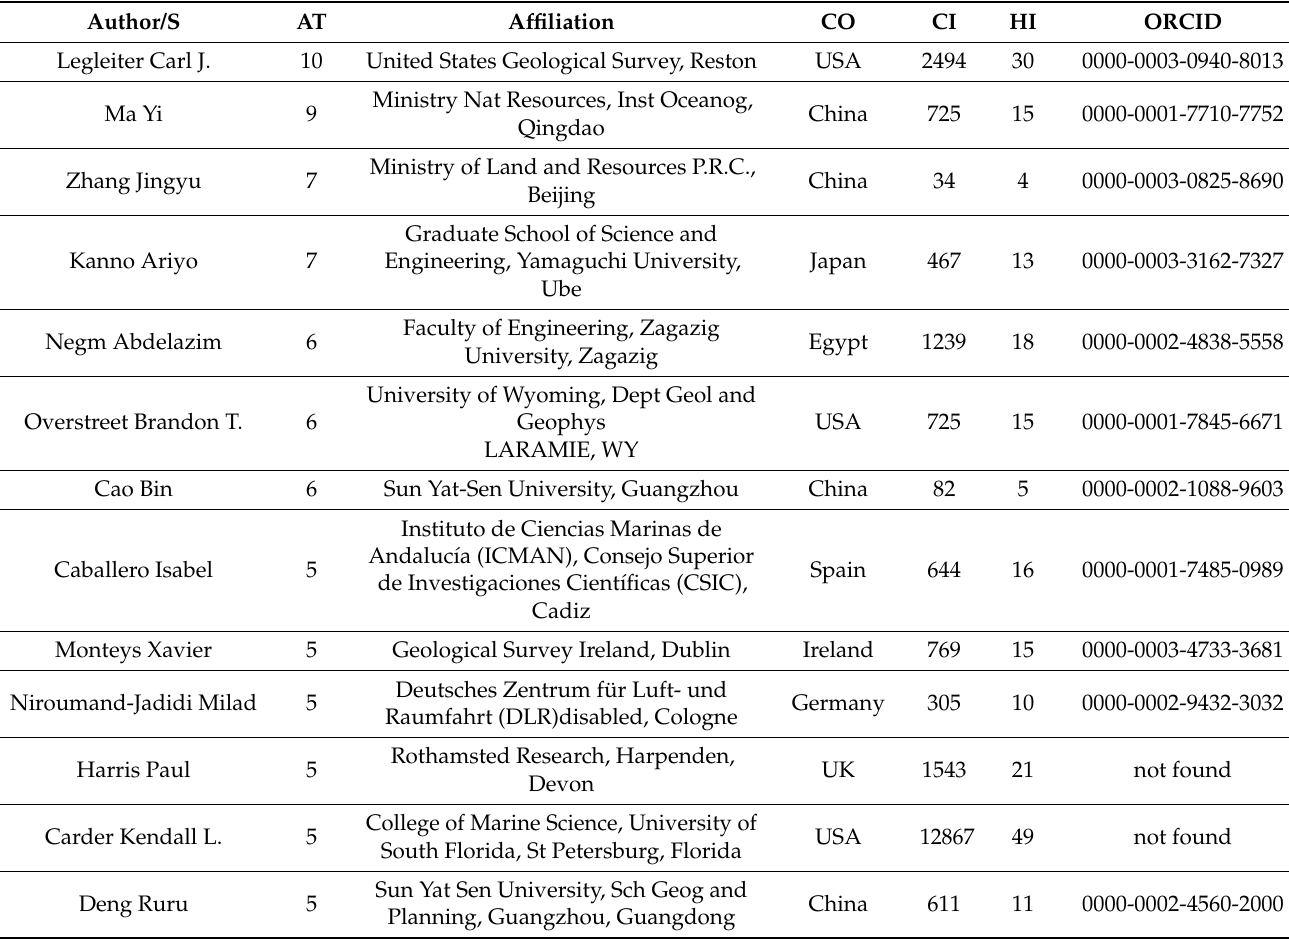
Figure 10. Most relevant corresponding authors that published articles dealing with optical SDB. Table 5. Authors with five and more publications related to optical SDB—only from the WoSCC Table 4. Authors with six and more publications related to SDB (WoSCC and Scopus databases).